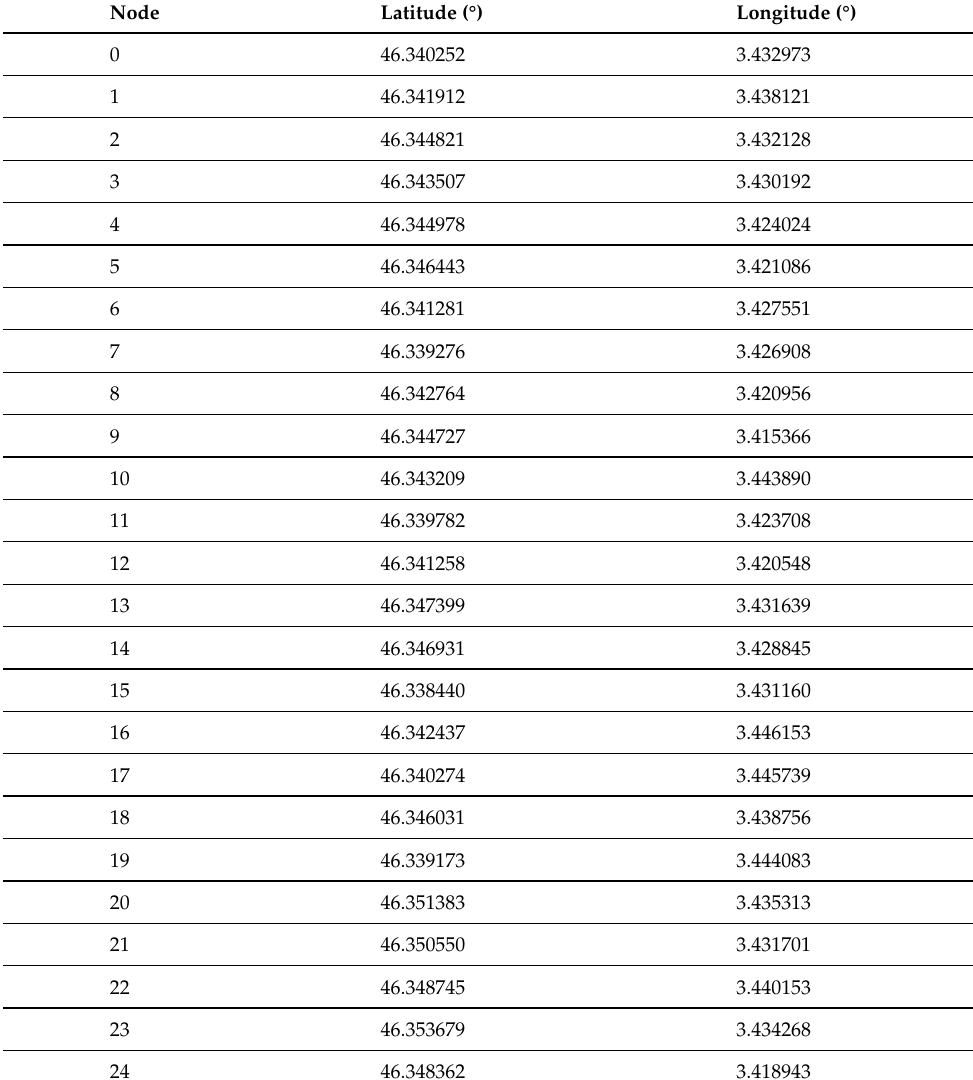
Table A1. List of the 25 nodes used to test the optimization algorithms. The coordinates are given in the WGS84 reference